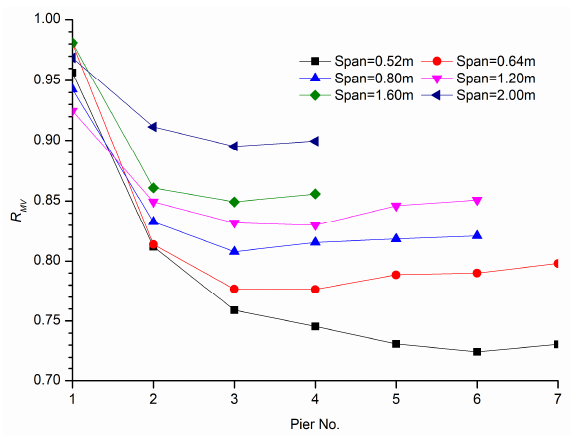
ff erent MV of each pier in di